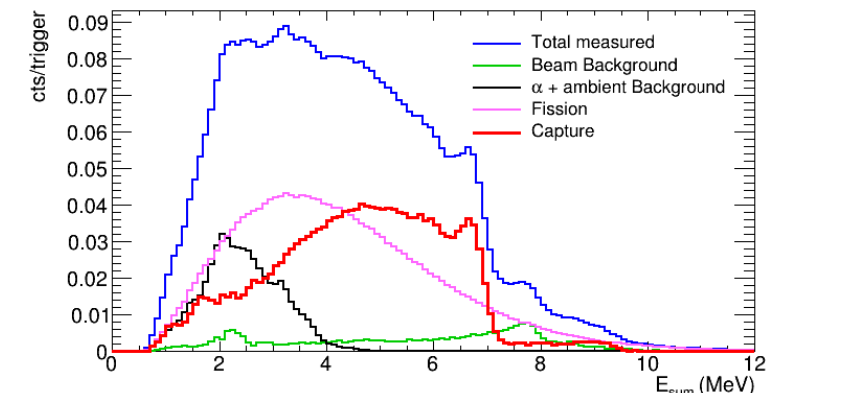
Fig. 10. Contributions to the deposited energy spectra in the TAC in the capture resonance at 2.1 eV < E n < 2.5 eV for 2 < m cr <